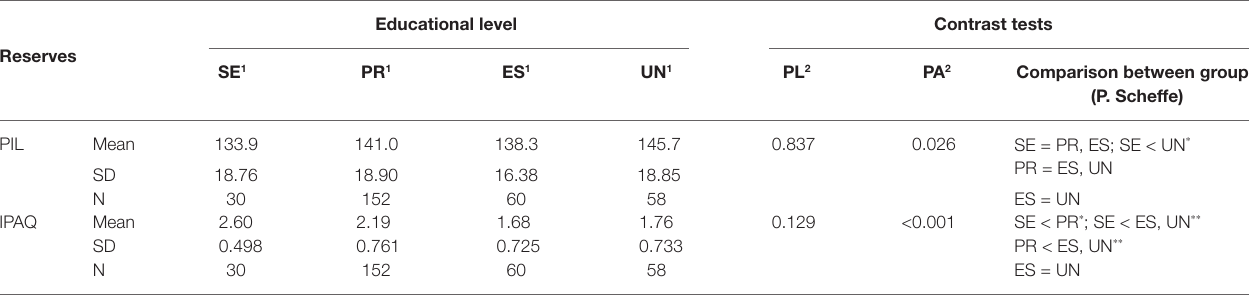
Educational level Contrast tests